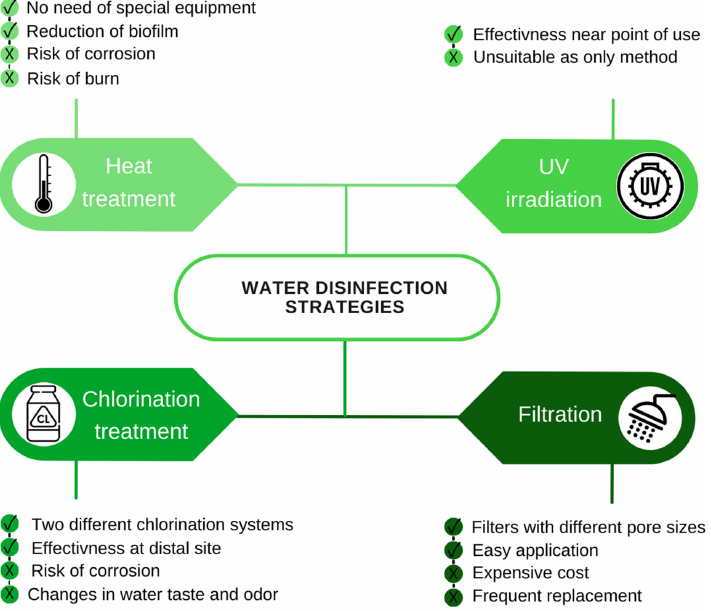
√ ) and cons ( × ) of the mainly adopted water disinfection Figure 1. Pros ( √ ) and cons (×) of the mainly adopted water disinfection strategies. Figure 1. Pros (